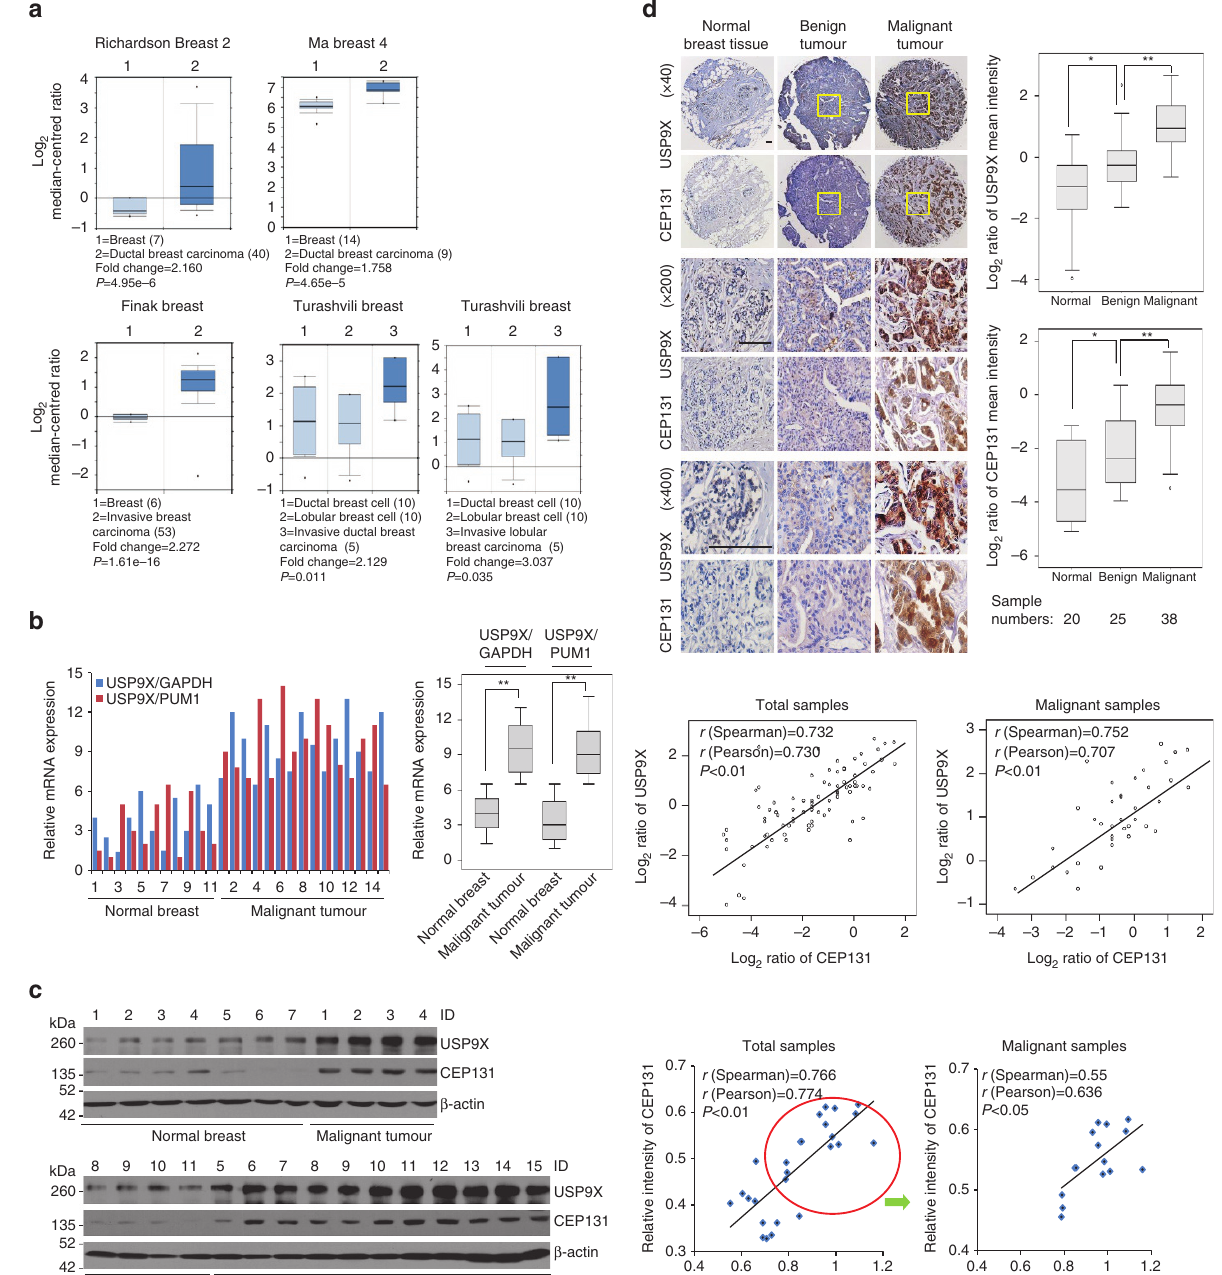
Figure 6 | The expression of USP9X and CEP131 is elevated and correlated in breast cancer. ( a ) Box plots of USP9X transcript levels in normal human mammary tissues and breast carcinoma samples based on four independent data sets from Oncomine. ( b ) The expression level of USP9X in 11 normal mammary tissues and 15 breast carcinomas was quantified by qRT–PCR and normalized as indicated. ** P o 0.01, Student’s t -test. ( c ) Cellular extracts from 11 normal mammary tissues and 15 breast cancer samples were prepared for western blotting analysis (left panel). The expression level of USP9X was quantified by the Image J software and normalized to b -actin. The correlation coefficient and P values are shown (right panel). ( d ) Immunohistochemistry analysis of the expression levels of USP9X and CEP131 in breast tumours (upper left panel). Representative images were collected in three different magnification fields. Scale bars, 50 m m. The scores of the stained sections were determined by evaluating the intensity of immunopositivity by the Image- pro Plus software and were presented with box plots (upper right panel). Values that are less than or equal to the first quartile minus 1.5 times the interquartile range, or are greater than or equal to the third quartile plus 1.5 times the interquartile range are defined as outlier ones and indicated with a circle. * P o 0.05; ** P o 0.01, one-way ANOVA. The correlation coefficient and P values are analysed as indicated (lower